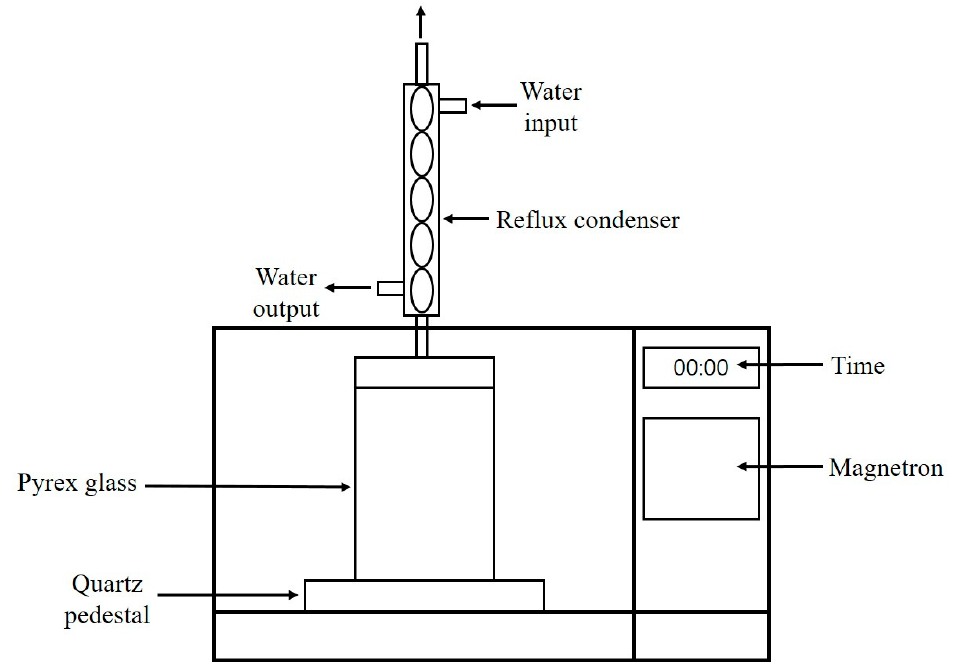
Figure 1. Schematic diagram of microwave-assisted leaching system.